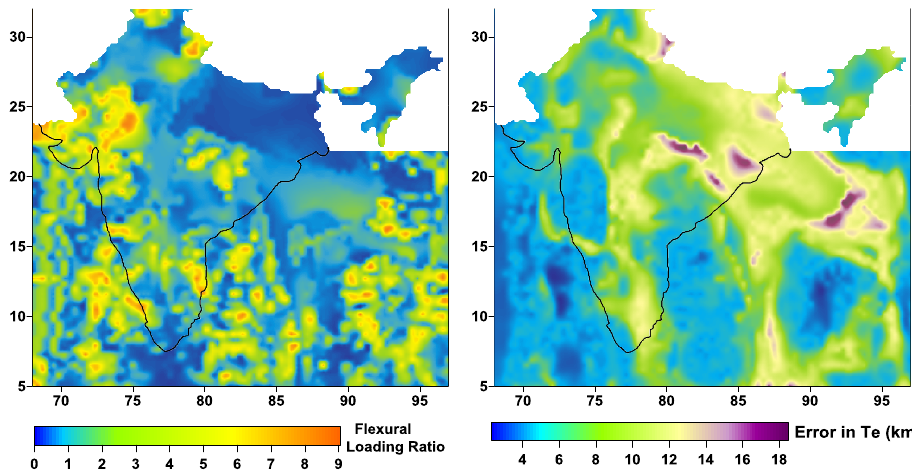
Figure 4. (a) Flexural loading ratio. (b) Error in the estimation of the